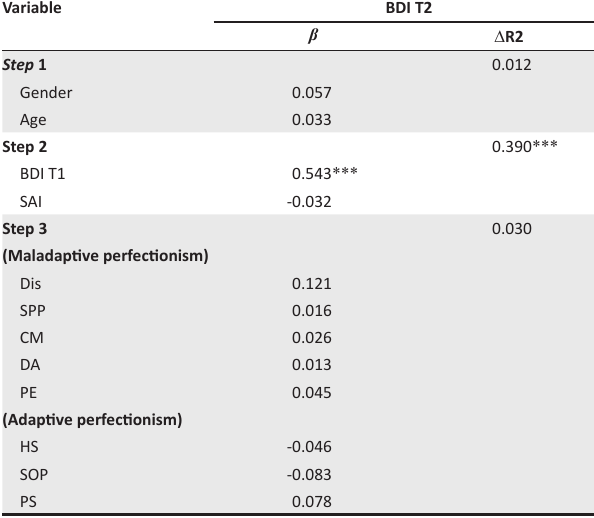
TABLE 4: Regression of BDI T2 on perfectionism T1 after controlling for BDI T1 (longitudinal analyses). Variable BDI